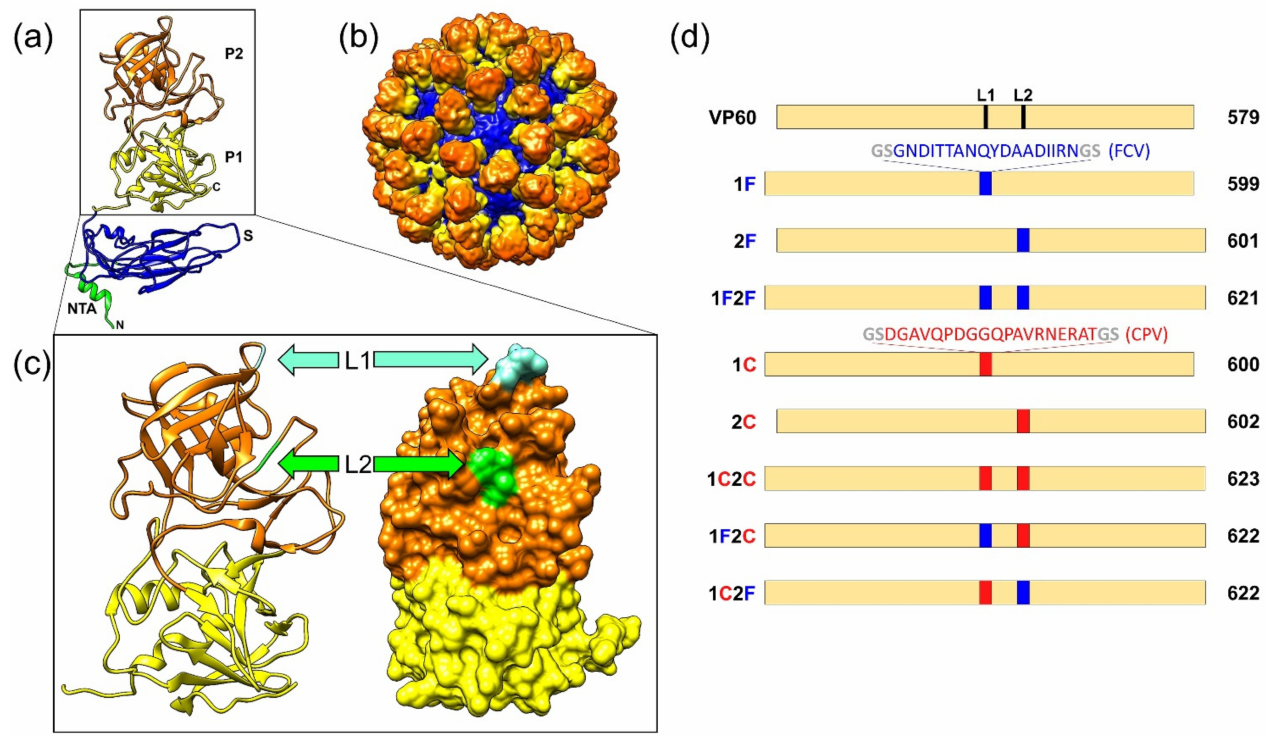
Figure 1. Design of the VP60 insertion mutants generated in this study. ( a ) Ribbon representation of the VP60 protein structure (Protein Data Bank [PDB] accession number 3J1P). The NTA, S domain, and P1 and P2 subdomains are indicated. ( b ) Three-dimensional cryo-EM map of RHDV capsid radially color-coded as in ( a ). ( c ) Ribbon (left) and surface (right) representations of the VP60 P domain. Positions of insertion sites at loops L1 and L2 are indicated. ( d ) Schematic representation of the VP60 chimeric constructs showing names (left) and protein lengths in amino acids (right). The amino acid sequences depicted in blue (FCV B-cell epitope, FCV22) and red (CPV B-cell epitope, 2L21) were incorporated at the indicated positions in each chimeric